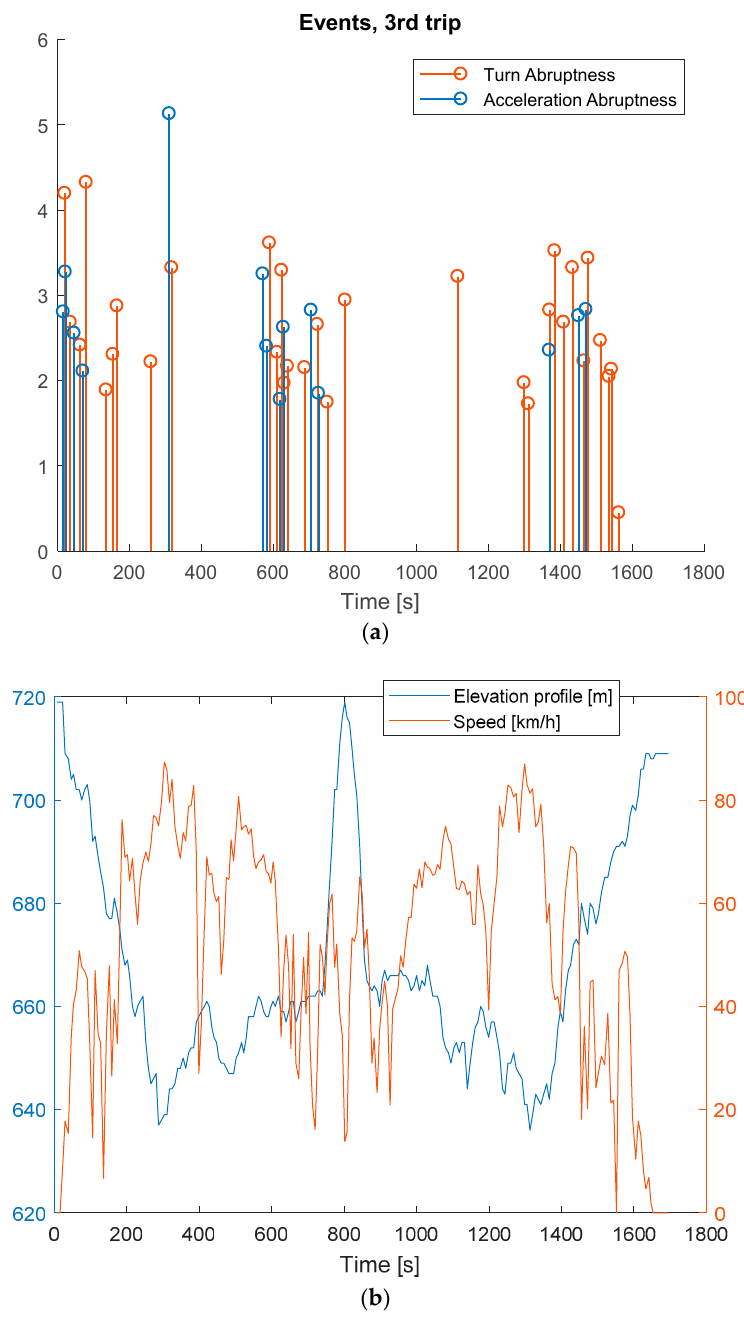
Figure 14. ( a ) Detected events during Trip #3 ( b ) Speed and elevation profiles during Trip #3.